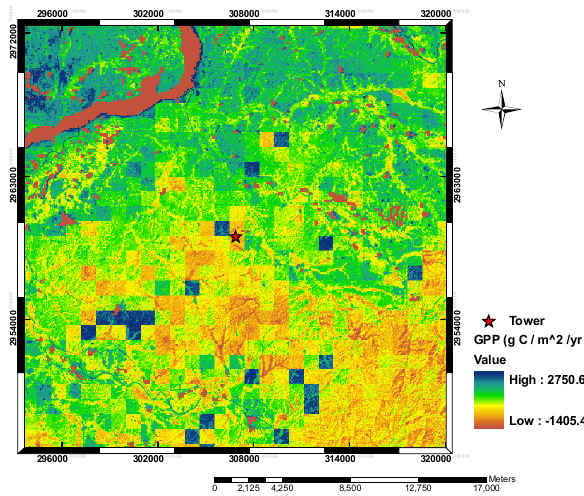
Fig. 6. A comparison of overall 8-day gross primary production (GPP) values between the observed (EC-derived) and predicted (remotely sensed) in 2004 at an ecosystem scale in an evergreen needleleaf forest at QYZ, China.